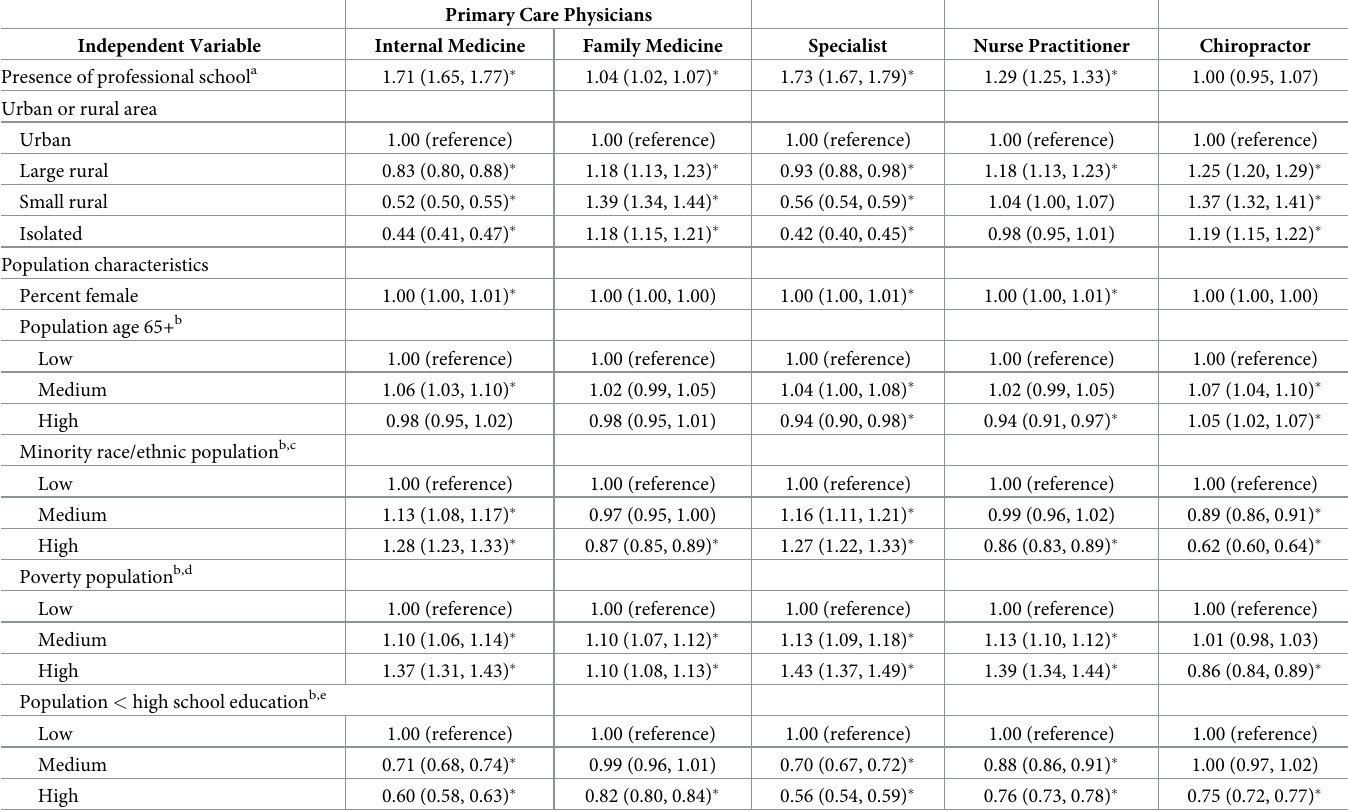
Table 3. Adjusted rate ratios for the association between population characteristics and provider spatial